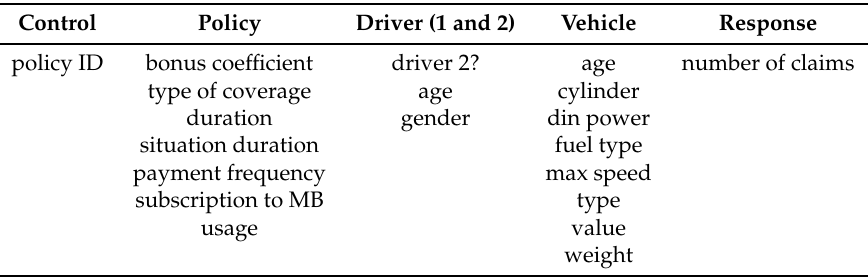
Table 1. Variables in our